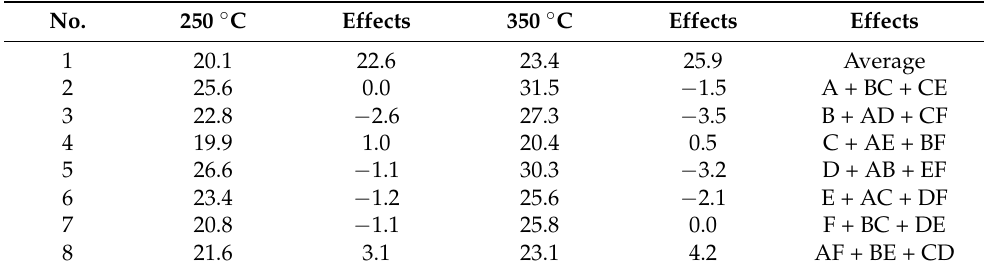
Table 9. Average values and standardised effects with respect to zone I. Values in mg.